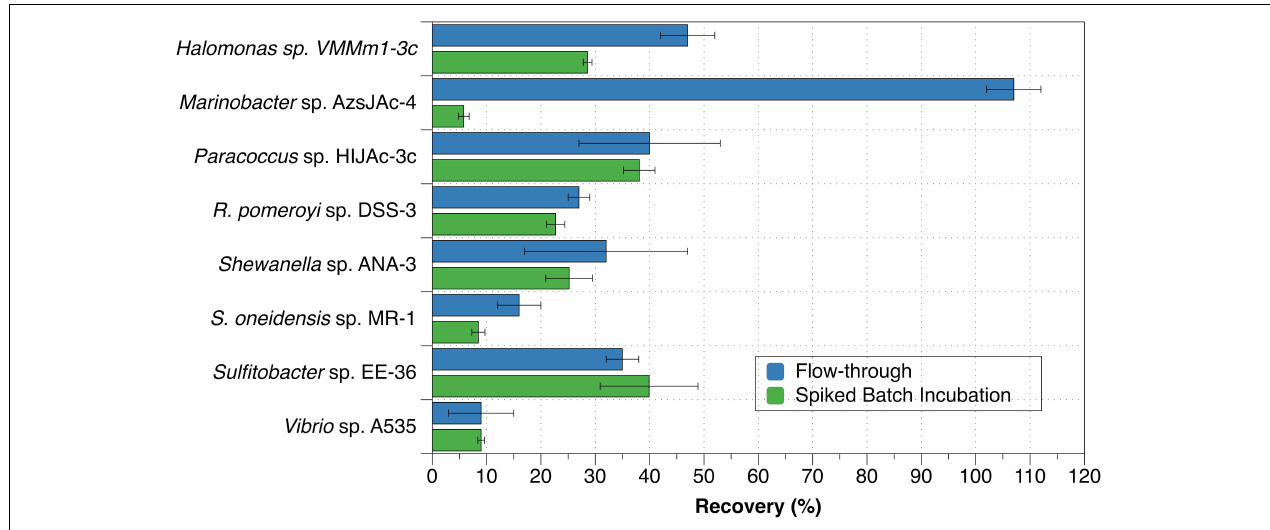
FIGURE 1 | Recovery percentages for bacterial strains evaluated with both spiked batch incubations (green bars) and flow-through method (blue bars). Uncertainties represent the standard deviation.